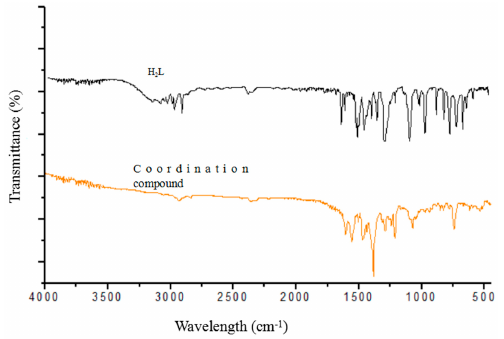
Figure 1. The infrared spectra of the ligand H 2 L and its Zn(II)-La(III) coordination